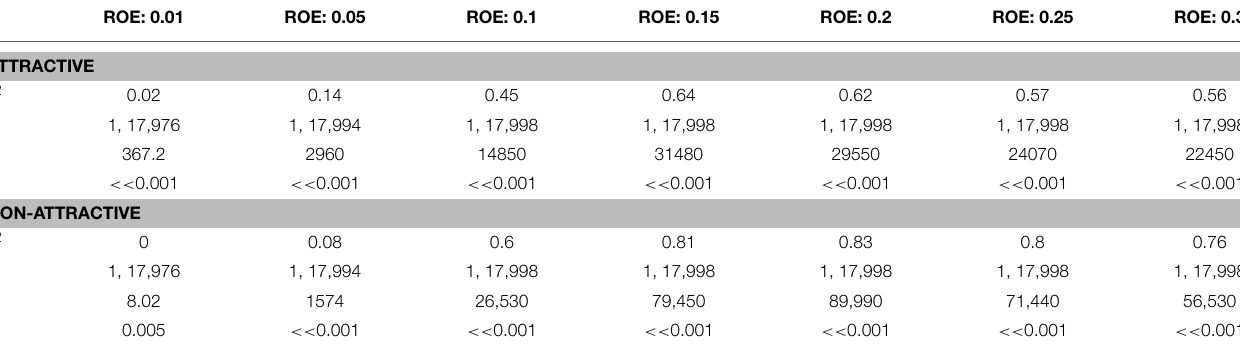
TABLE 2 | Increasing exponential decay model summaries generated by Monte Carlo methods for simulated trap catch disruption under attractive and non-attractive